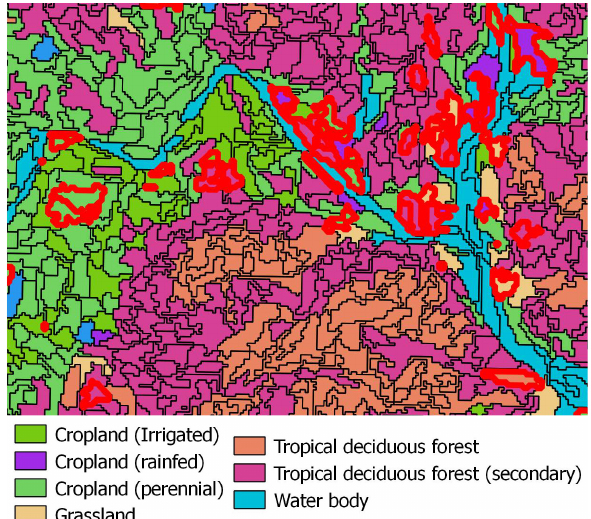
Figure 7: Landsat 8 based updated segmentation (2014) Probable classification by C5 algorithm. Red objects were the “uncertain” segments before visual